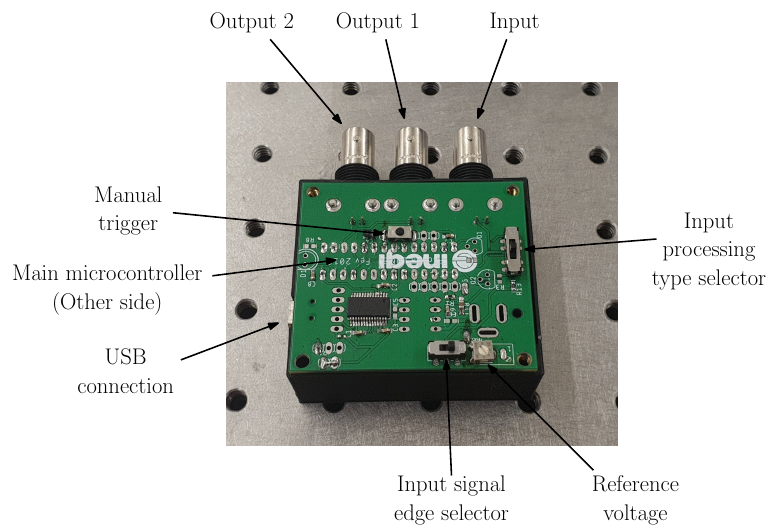
Figure 3. Photo of the developed trigger controller.